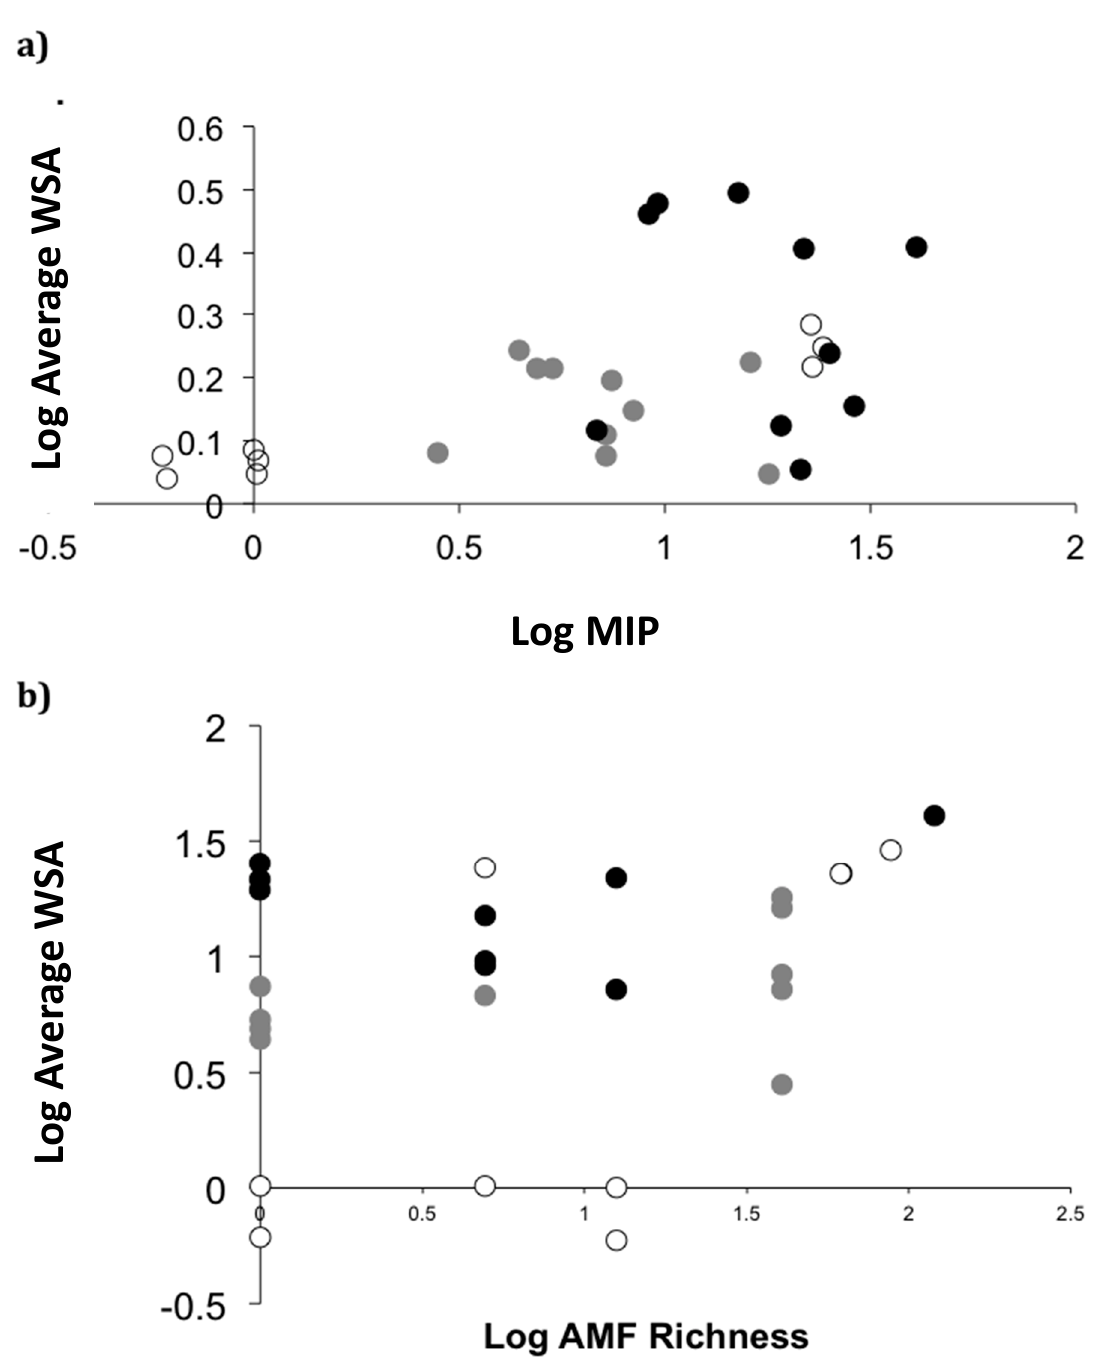
Figure 4. Scatterplot of ( a ) log of Mycorrhizal Inoculum Potential (MIP) and log of average Water Stable Aggregates (WSA) and ( b ) log arbuscular mycorrhizal richness and log average WSA. Unfilled dots represent sites with native vegetation, gray dots represent sites with agricultural disturbance, and filled black dots represent plant invaded sites.